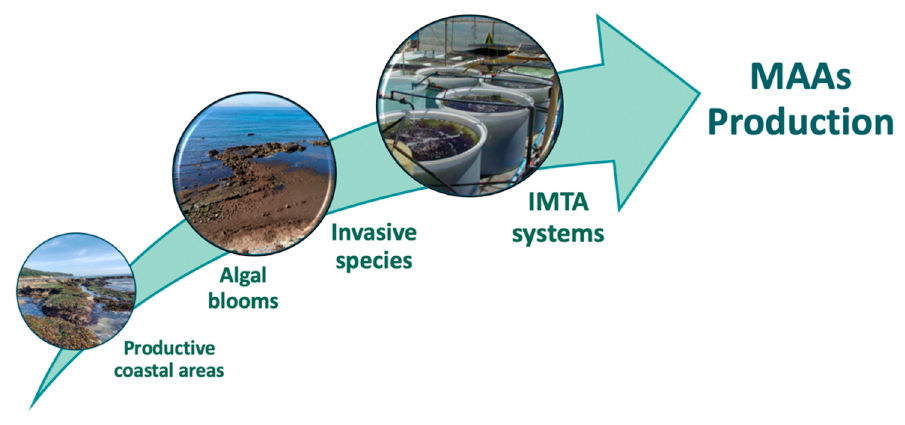
Figure 4. Scheme of the most important source of biomass for MAA production.